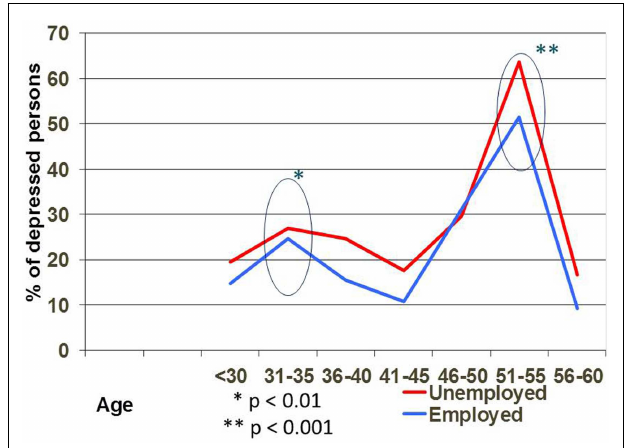
FIGURE 4 | Depression rate on different age in employed and unemployed persons .